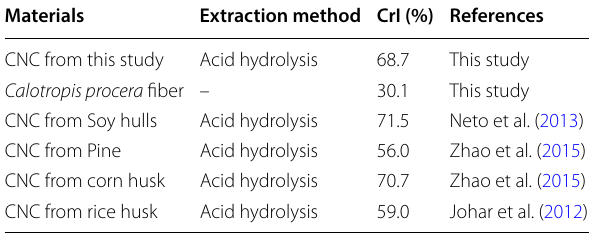
Table 3 The crystallinity index (CrI) of the obtained CNC in this study and comparing with the reported literature